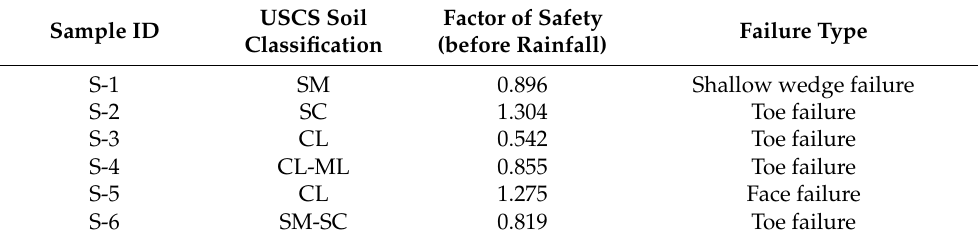
Table 3. The factor of safety and failure types from different slopes (S-1 through